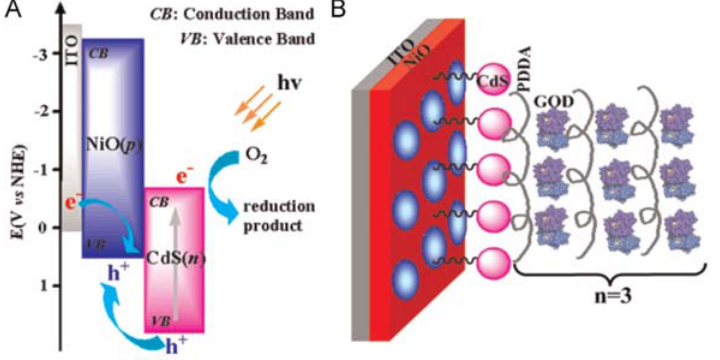
Figure 8. ( A ) Schematic diagrams for energy bands of n-CdS and p-NiO and photocurrent genera-